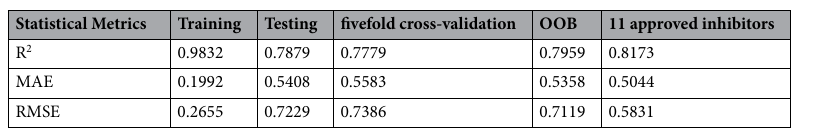
Table 4. The QSAR model performance on the training and testing dataset for VEGFR2 inhibitors. R2, Correlation coefficient; MAE, Mean absolute error; RMSE, (root-mean-squared error).